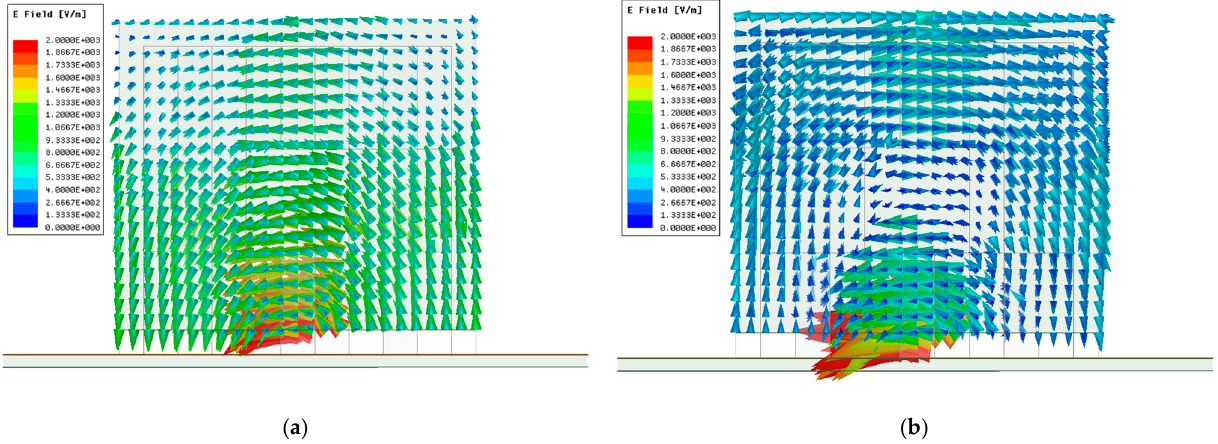
Figure 9. Electric field distributions of modified menger sponge fractal DRA. ( a ) 2.45 GHz; ( b ) 2.9 GHz.